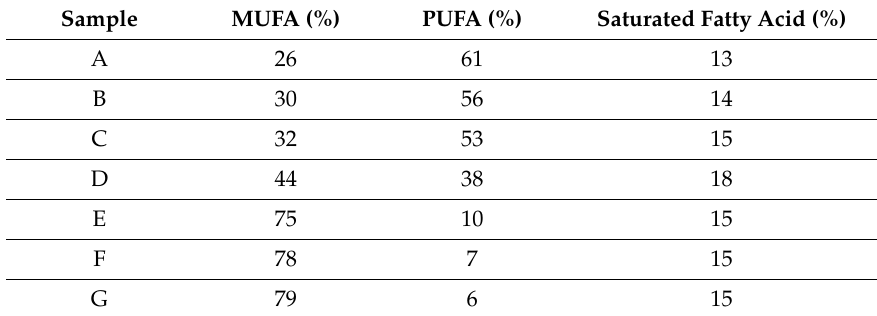
Table 1. The monounsaturated fatty acids (MUFA), polyunsaturated fatty acids (PUFA), and saturated fatty acid content in the samples